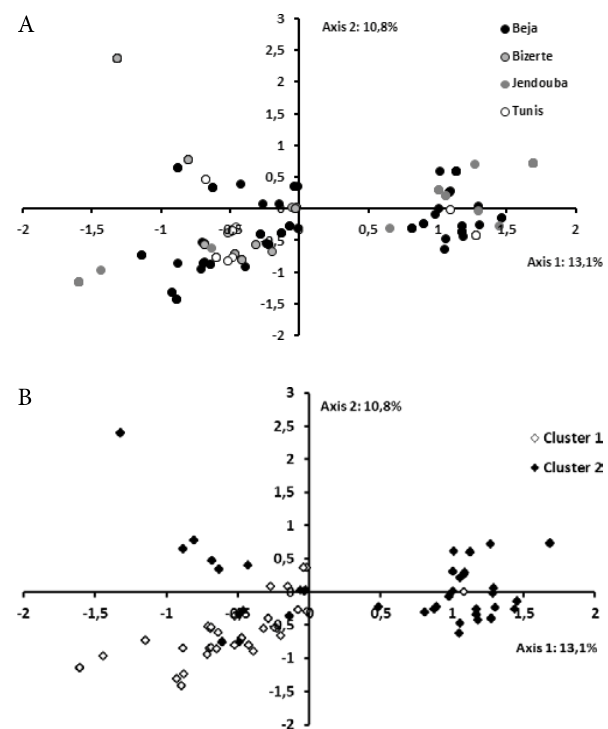
Figure 2. Principal component analysis (PCA) realized on the Ascochyta fabae sub-populations sampled from the five locations in Tunisia in 2012. A : isolates were assigned to their respective location (Beja, Bizerte, Jendouba, Kef, or Tunis), B : isolates were assigned to their respective clusters (C1, C2, or C1/C2) estimated with STRUCTURE (k = 2, deltak =